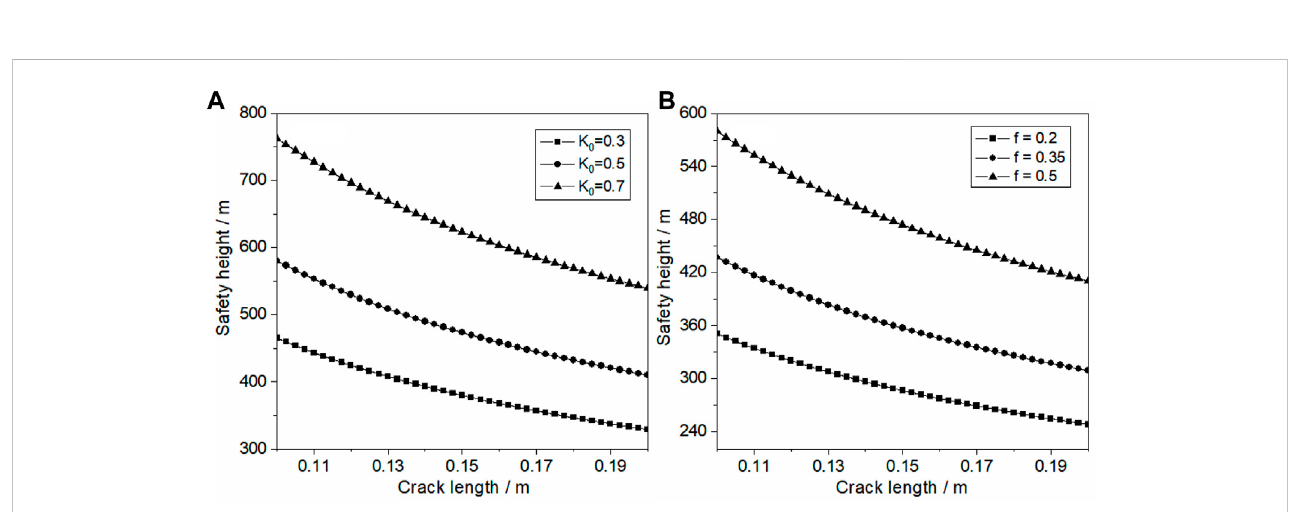
FIGURE 9 Variation in the slope safety height with the crack length: (A) in fl uence of the side-pressure coef fi cient and (B) in fl uence of the side-friction coef fi cient.